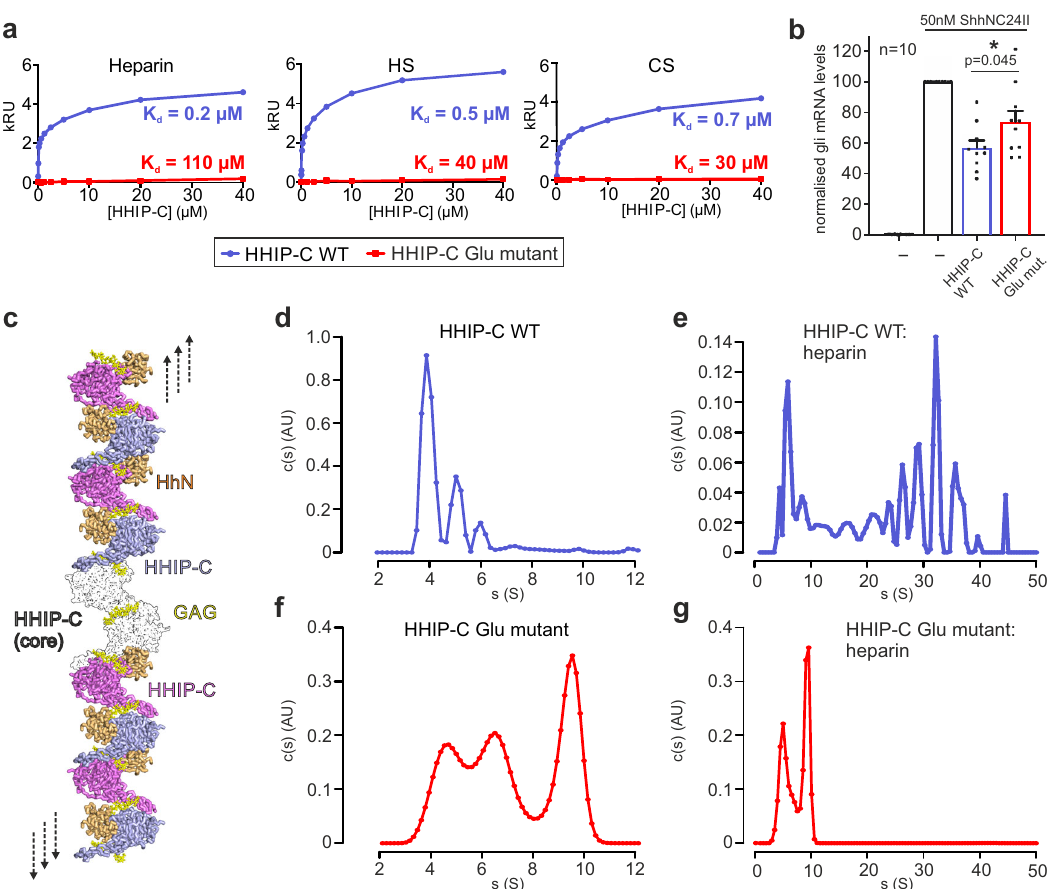
Fig. 5 Analysis of HHIP-C:GAG interactions and oligomerisation. a Comparative SPR curves for HHIP-C WT (light blue) and HHIP-C Glu mutant (red) binding to heparin, heparan sulphate (HS) and chondroitin sulphate (CS); b Quanti fi cation of HH pathway inhibition with the addition of HHIP-C WT or HHIP-C Glu mutant. Relative levels of Gli1 mRNA were quanti fi ed from 10 independent experiments, with statistical signi fi cance calculated using a two- tailed, paired t-test with p = 0.045; Data are presented as mean values± SEM. c Model for cell surface HHIP-C oligomeric assembly. GAG chains (represented by heparin, yellow) stabilise a core anti-parallel HHIP-C dimer (surface; black and white) and can then recruit further HHIP-C chains (light blue, violet) to form long oligomeric chains. This facilitates binding and antagonism of multiple HhN ligands (orange). d , e AUC experiments to assess the oligomerisation of HHIP in solution, comprising HHIP-C ( d ) and HHIP-C:heparin 30-mer complex ( e ); f , g As in ( c , d ), comprising HHIP-C Glu mutant ( e ) and HHIP-C Glu mutant mixed with 30-mer heparin ( f ). Source data are available as Source Data fi